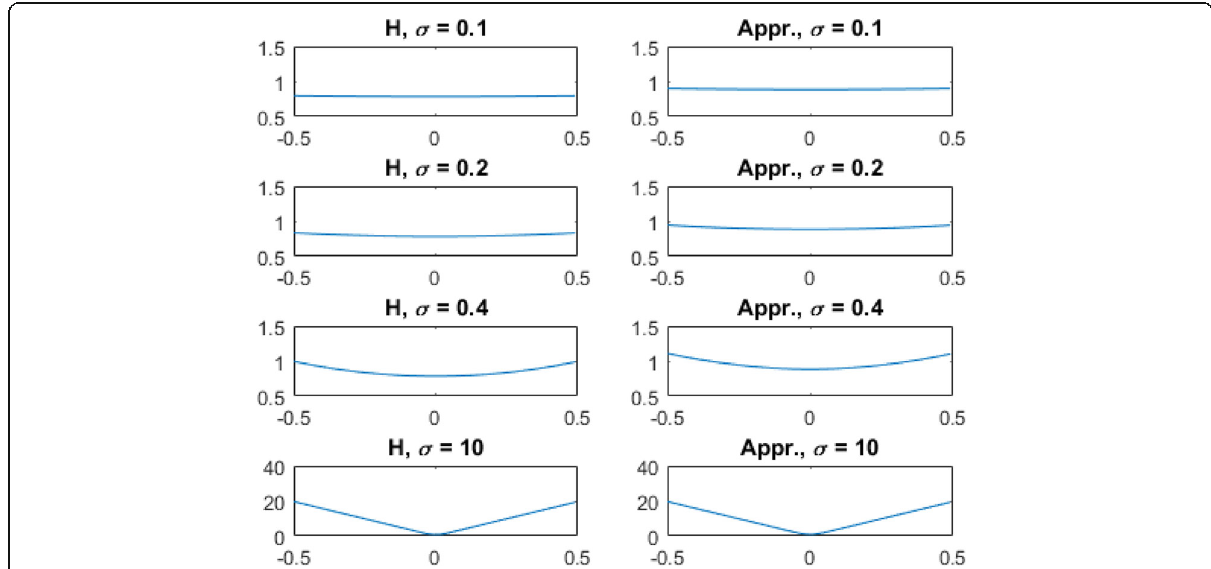
Fig. 1 Some examples of the tomographic filters for the 3D TOF BPF algorithm with different σ values in the Ω = Ω π /2 case. Left : Fourier domain transfer functions (7). Right : Approximations